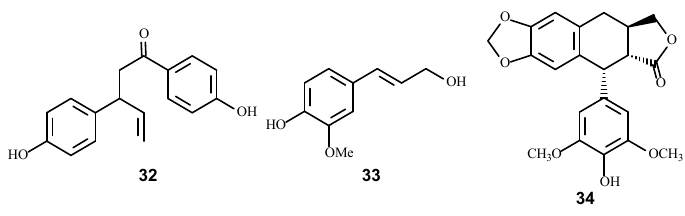
Figure 1. The chemical structures of compounds 1 – 34 .